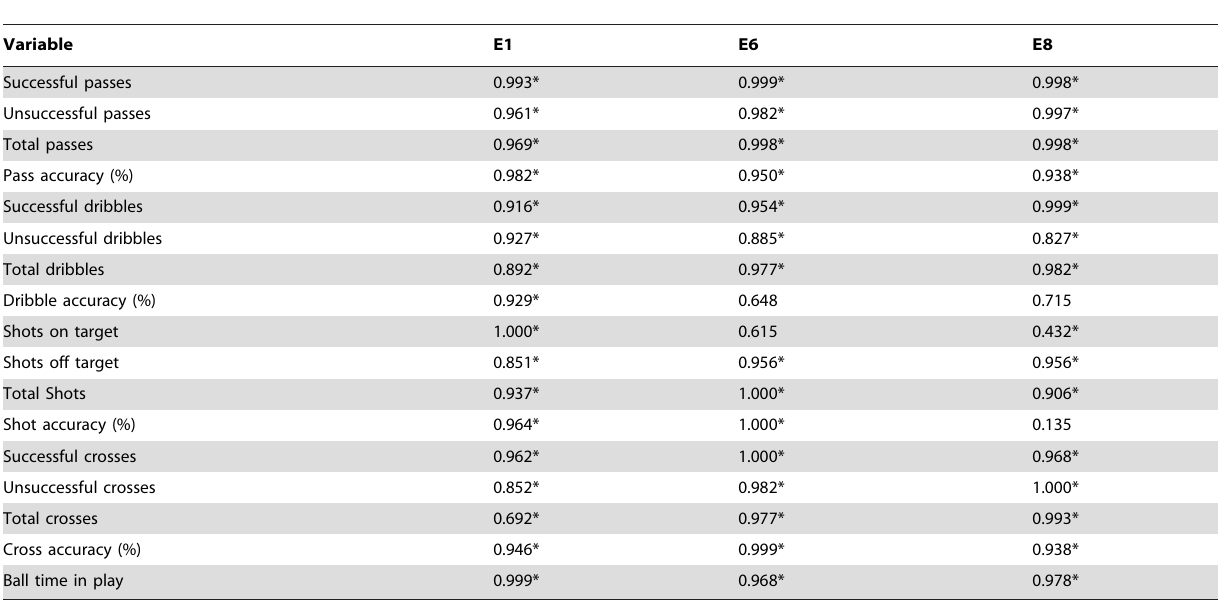
Table 2. Test-retest reliability data (intraclass correlation coefficients) for the technical variables examined.